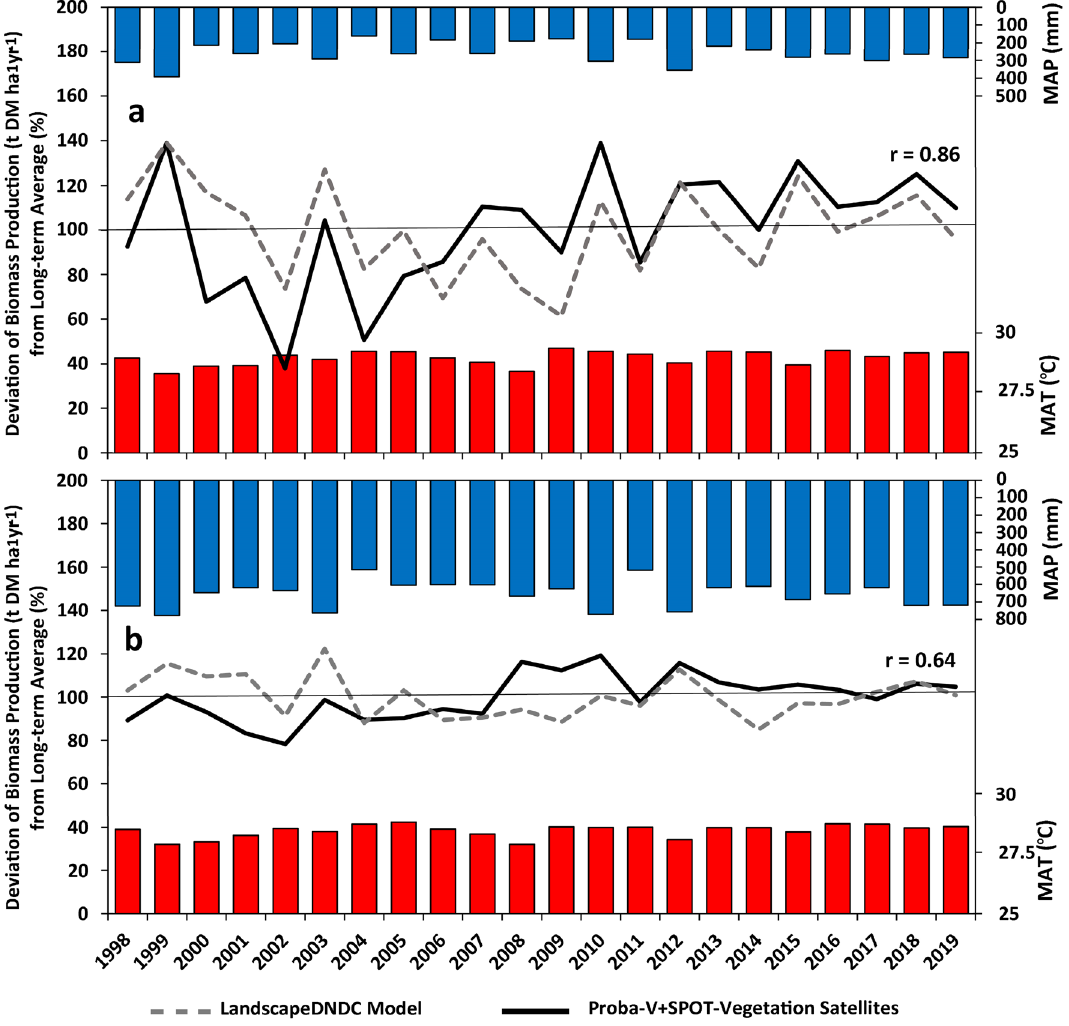
Figure 1. Mean Annual Precipitation (MAP), Mean Annual Temperature (MAT), as well as the deviation of total biomass production (t DM ha −1 yr −1 ) from long-term average (%), simulated with LandscapeDNDC model and estimated with the remote sensing data (ACF product, the Proba-V and the SPOT-vegetation satellites) over the Sahelian ( a ) and Sudanian ( b ) part of the study domain (the anomaly is shown on a scale between 0 and 200%). The figure was generated using Microsoft Excel 2016 (https:// www. micro soft. com/ de- de/ micro soft- 365/ tonnes ha −1 , with a meanof ~ 0.1 tonnes ha −1 in the Sahelian and ~ 0.6 tonnes ha −1 in the Sudanian zone, respec- tively. For those grids predominantly covered with extensive pastoral lands, natural pasture, crop residues, and browsing provided ~ 70.0, ~ 28.5, and ~ 1.5% respectively of the total feed. In contrast, grids dominated by mixed crop-livestock systems, indicated a considerably higher dependence on crop residues, reflected by a contribution of ~ 53.0, ~ 46.0, and ~ 1.0%, for natural pasture, crop residues, and browsing, respectively. In the great majority of the study area (~ 94%), mostly belonging to the Sudanian zone, there was decreased biomass production (~ 10.0% per decade). By contrast, for the Sahelian zone, biomass production and thus energy supply to livestock increased by about ~ 3.4% per decade (with the maximum increase of ~ 5.1% per decade). This is consistent with field measurements on herbaceous mass and satellite observations for the study area 41 , which estimate that the total vegetation production from the woody and herbaceous plants has increased by ~ 6.0–20.0% for the period 1987–2016. The observed increases in productivity for the Sahelian zone are closely related to increases in annual precipitation (trend: ~ + 0.7 mm yr −1 ), which have particularly altered early and